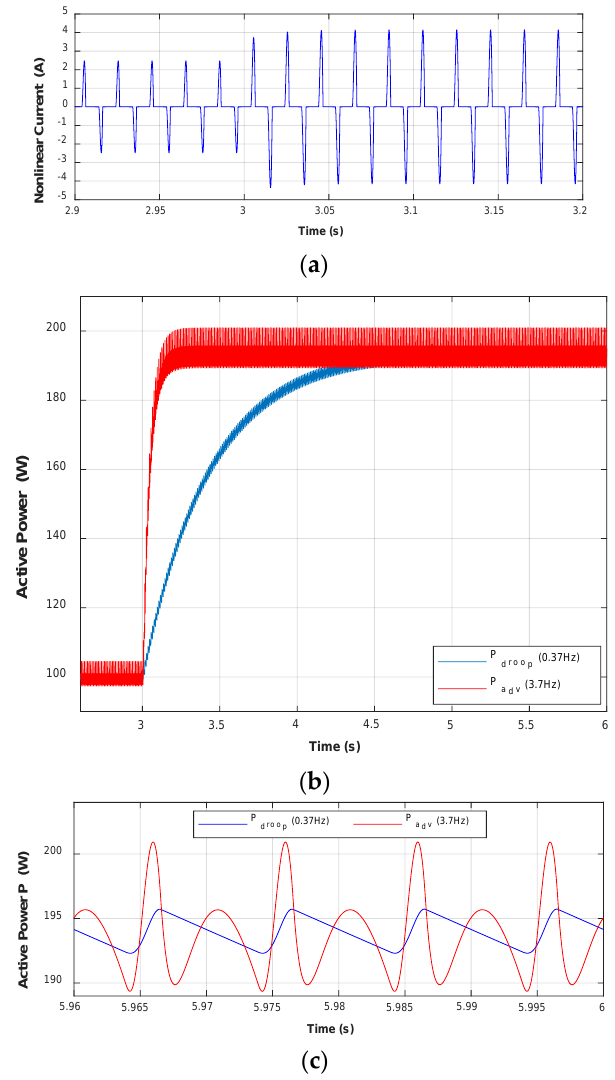
Figure 11. Simulation of the load current and P av transient responses for a nonlinear Diode Bridge